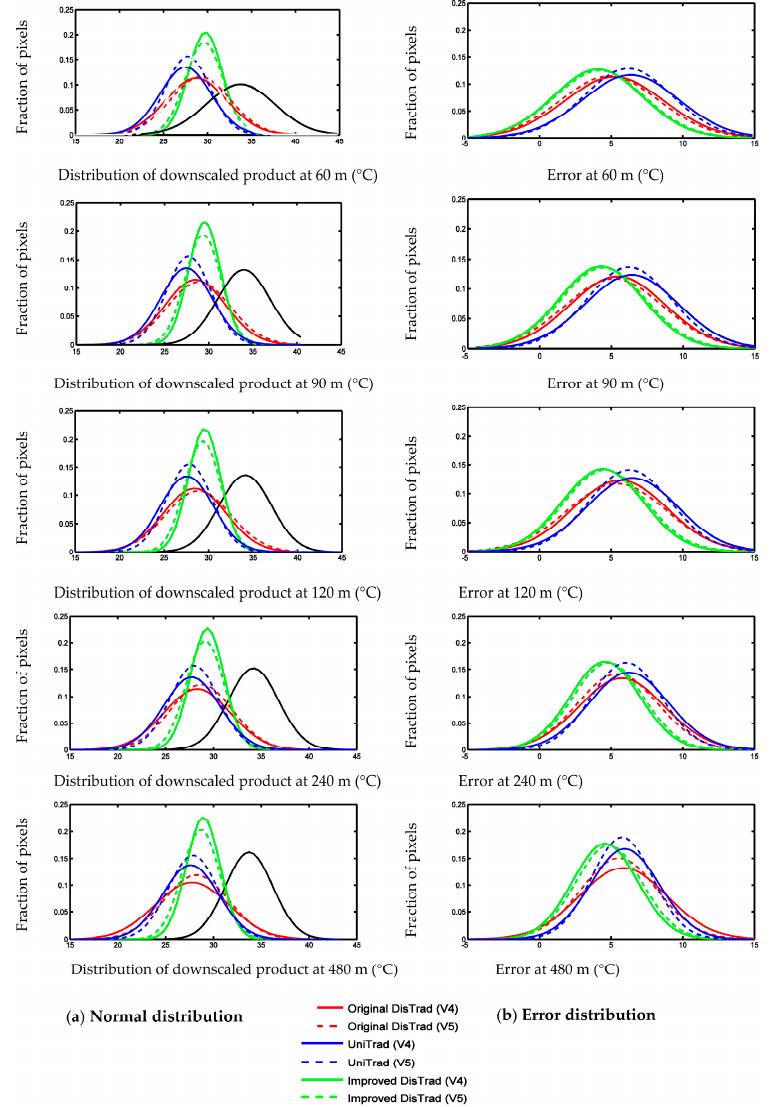
Figure 13. The left side ( a ) shows the normal distribution of the observed and sharpened products using the improved DisTrad (green), the original DisTrad (red), and UniTrad (blue) land surface temperatures for versions V4 (solid) and V5 (dotted). The right side ( b ) shows the error distribution, resulting from subtracting the sharpened products from the observed temperatures. The analyses are presented for different resolutions (e.g., 60, 90, 120, 240, and 480 m).